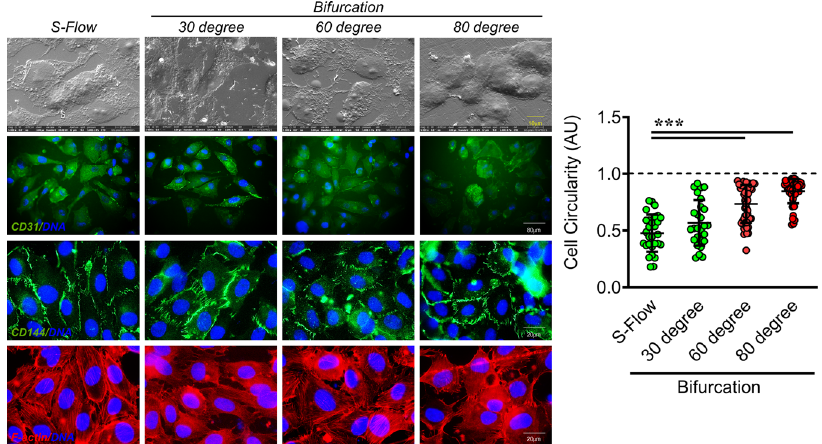
Fig. 6 Increasing bifurcation angles of coronary artery incrementally impacts the EC morphology. FE-SEM (top) based structural and surface level analysis of EC exposed to D-Flow using 30°, 60° and 80° microchannels. Magni fi cation: ×5000, Scale: 10 µ m. Flow exposed (4 h; 30°, 60° and 80° microchannels) EA.hy926 cells stained for cell-cell contact markers CD31 (second) and CD144 (penultimate). DAPI staining is shown in blue. Circularity of such cells was assessed using ImageJ. Cell circularity AU values per individual cells are indicated together with mean. Total number of cells, n ≥ 30. Values represent the mean ± SD. * p < 0.05, ** p < 0.01 and *** p < 0.001, by one-way ANOVA. Magni fi cation: ×50/×63, Scale: 80 µ m/20 µ m. Cell cytoskeletal F-actin (bottom) staining for EA.hy926 exposed to D-Flow (D-variable or D- fi xed regions) in 30°, 60° and 80° microchannels, using phalloidin. DAPI staining is shown in blue. Magni fi cation: ×63, Scale: 20 µ